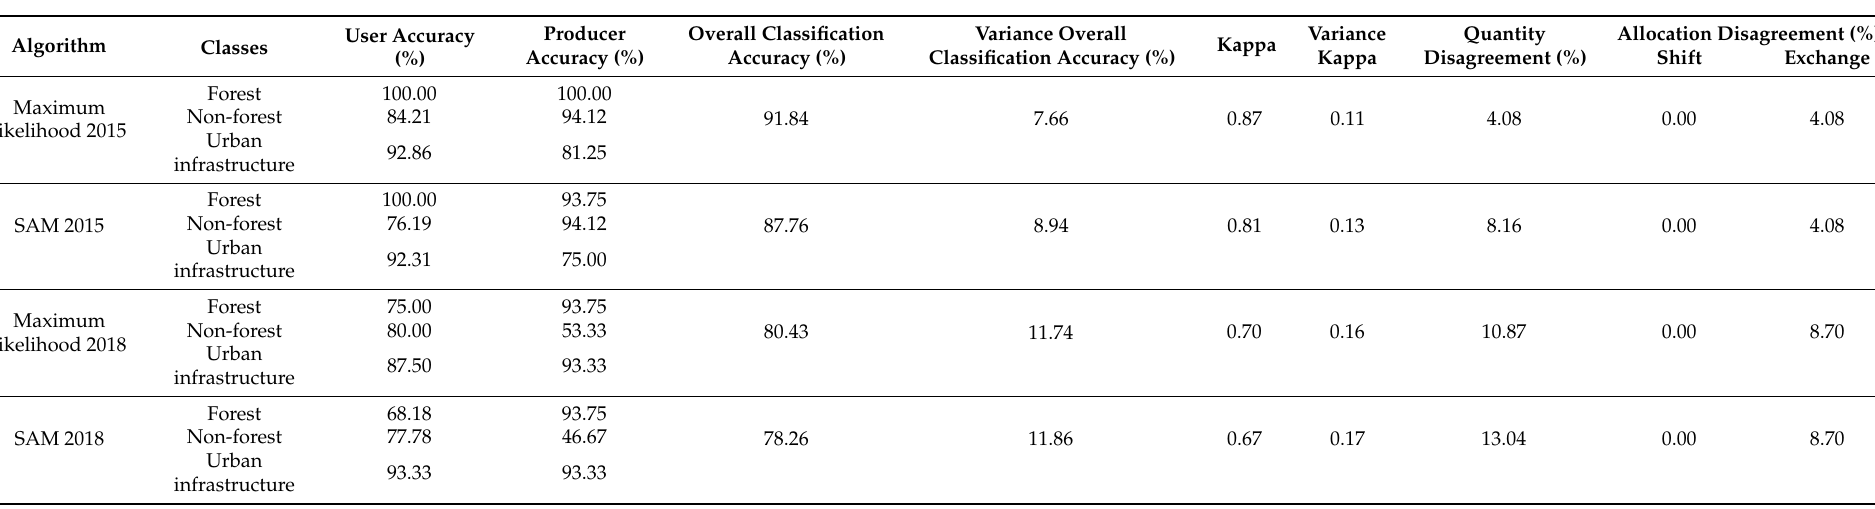
Table 3. Summary of evaluation techniques for the Maximum likelihood and Spectral angle mapper classifications for 2015 and